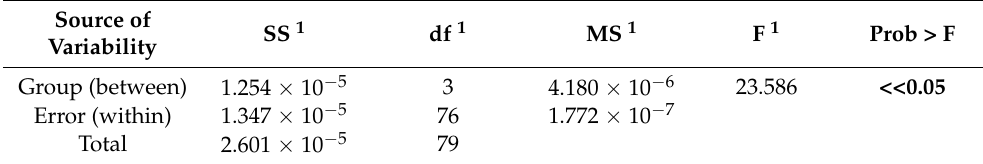
Table 1. The results of the ANOVA, where each of the 4 groups (Ce6 + Pheo, Ce6, Pheo, PS − ) Figure 4. The representative 2D-RI maps of E. coli cells incubated without PS ( A ) and incubated with represent the set of average RI of E. coli cells after 24 h Ce6 + Pheo ( B ), Ce6 ( C ), or Pheo ( D ).